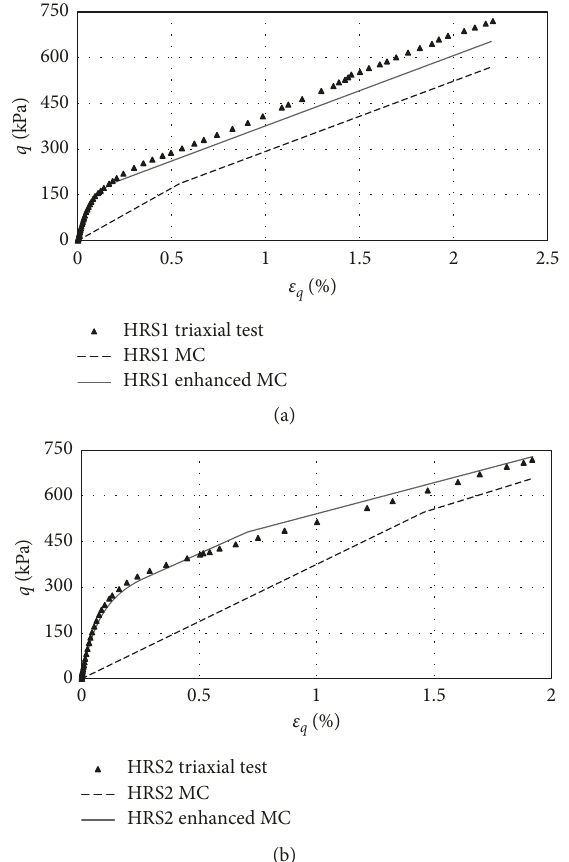
Figure 9: Variations of deviatoric stress in Ham River sand based on data from Jardine et al.